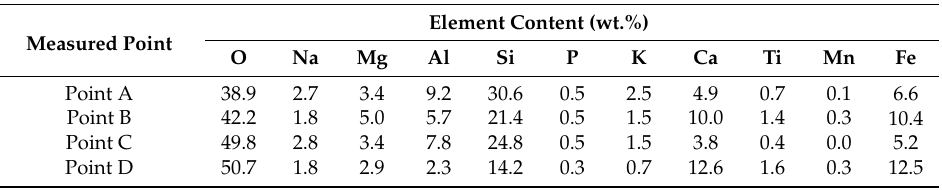
Table 4. The element contents of marked areas in Figures 5 and 7.